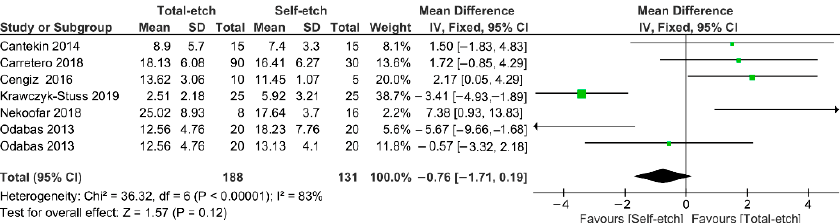
Figure 3. Findings of the meta-analysis of the bond strength of resin-based materials to Biodentine™ calcium silicate-based cement. Bond strength was similar between both strategies ( p = 0.12).